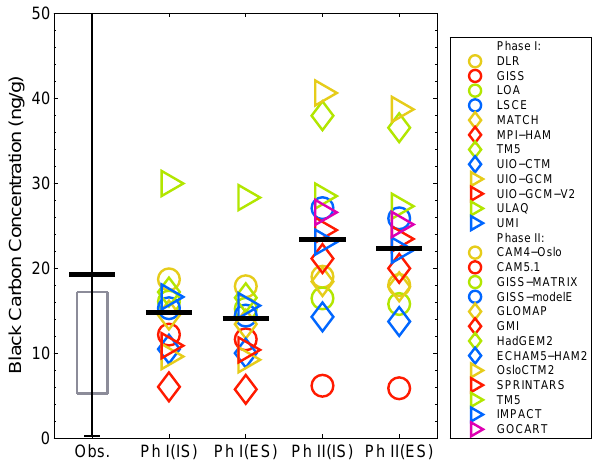
Fig. 1. Observed and modeled black carbon (BC) in snow concentrations in the Arctic. From left to right are ob- served BC-in-snow concentrations from Doherty et al. (2010), simulated concentrations over the observational domain from AeroCom Phase I models with inefficient meltwater scavenging (Ph I(IS)) and efficient scaveng- ing (Ph I(ES)), and simulated concentrations from Phase II models with inefficient scavenging (Ph II(IS)) and efficient scavenging (Ph II(ES)). The gray box indicates the 25% and 75% quartiles of the observations, and the whisker depicts the full extent of the observations. Note that the maximum value of 783.5 ng g − 1 is outside the figure. The bold horizontal line shows the mean of the observations and models for each scenario. Each colored dot represents the mean of a particular model’s simulated BC-in-snow concentration averaged over grid cells matching the location, time, and depth of measurements.